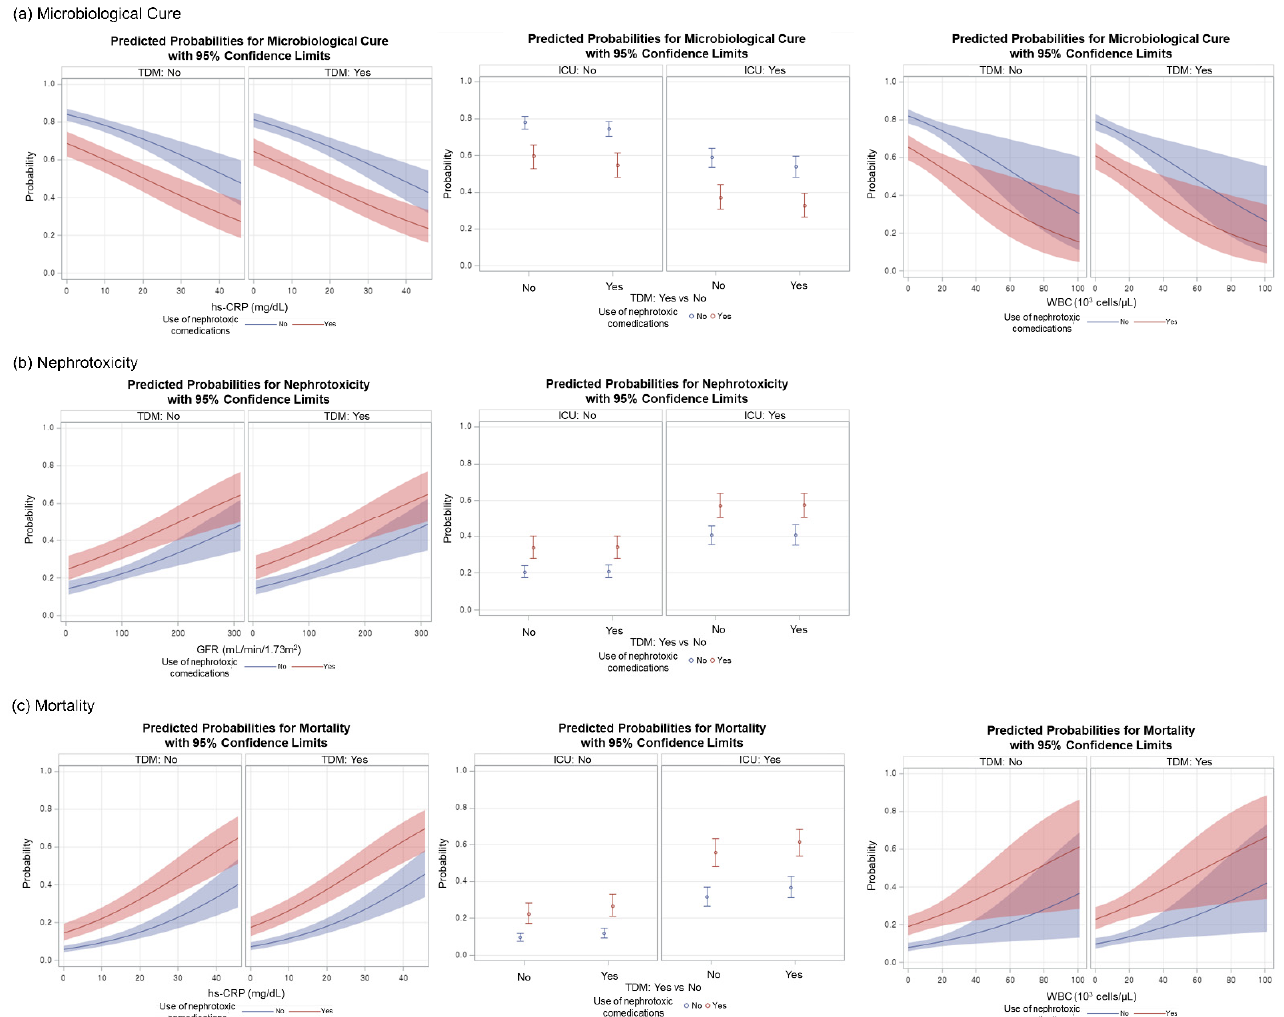
Figure 2. Predicted probability and their 95% confidence limits by TDM and other covariates for ( a ) microbiological cure, ( b ) nephrotoxicity, and ( c ) mortality: multiple logistic regression analysis. Abbreviations: TDM (therapeutic drug monitoring); ICU (intensive care unit); GFR (glomerular filtration rate); hs-CRP (high sensitivity C-reactive protein); WBC (white blood cell).